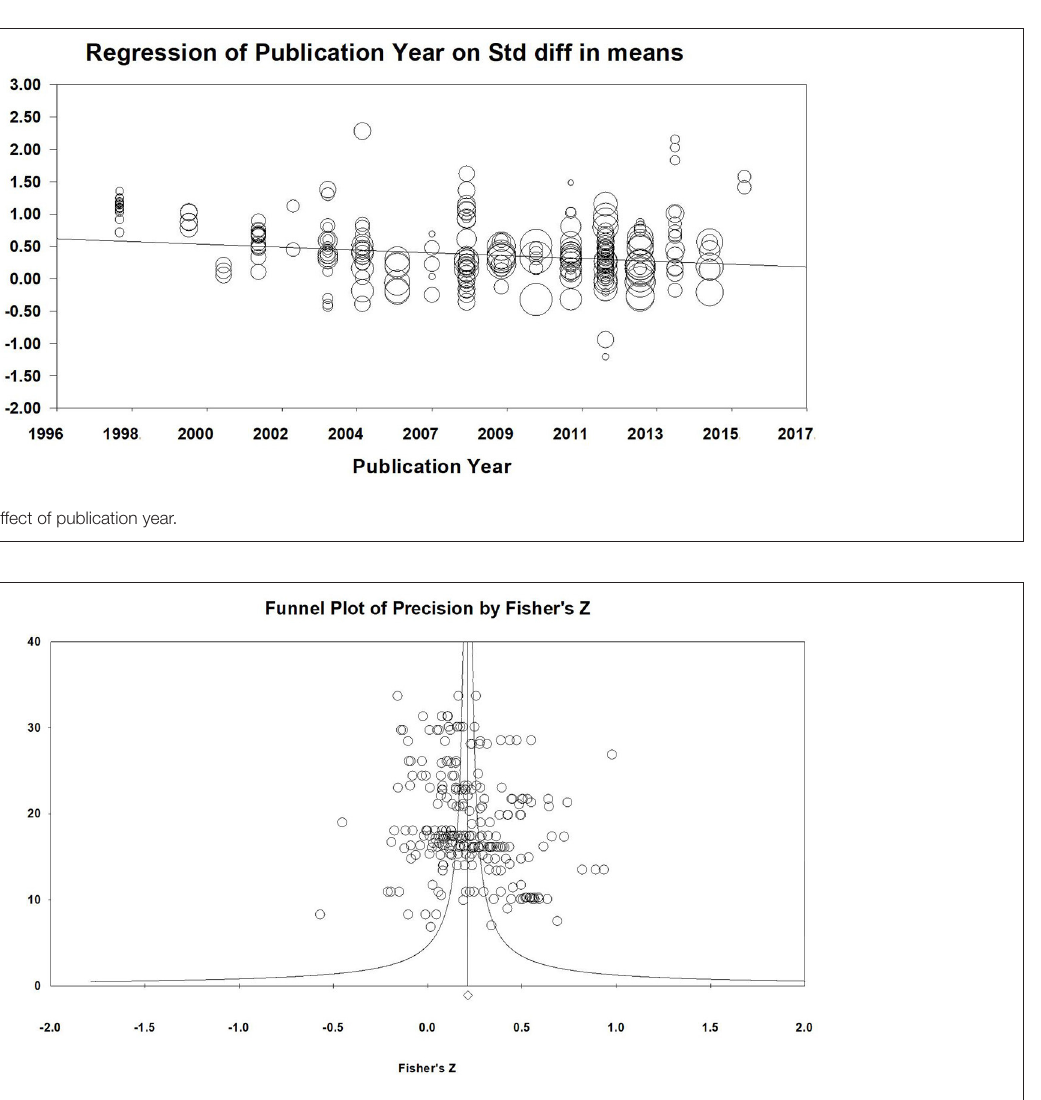
FIGURE 3 | Funnel